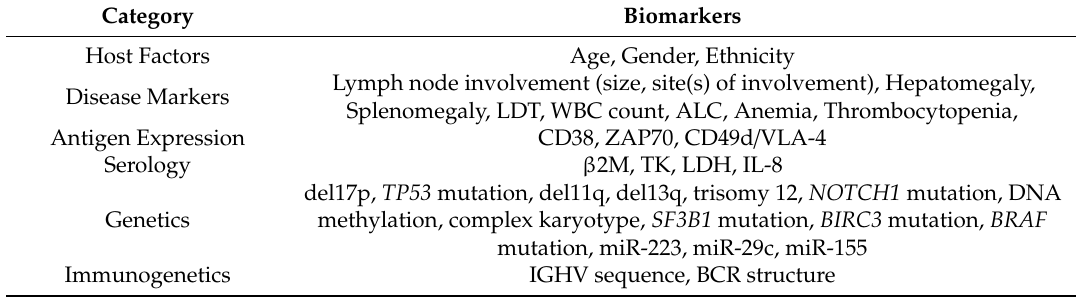
Table 1. Today’s most well-established prognostic biomarkers in chronic lymphocytic leukemia. Category Biomarkers Host Factors Age, Gender, Ethnicity Lymph node involvement (size, site(s) of involvement), Hepatomegaly, Disease Markers Splenomegaly, LDT, WBC count, ALC, Anemia, Thrombocytopenia, Antigen Expression CD38, ZAP70, CD49d / VLA-4 Serology β 2M, TK, LDH, IL-8 del17p, TP53 mutation, del11q, del13q, trisomy 12, NOTCH1 mutation, DNA Genetics methylation, complex karyotype, SF3B1 mutation, BIRC3 mutation, BRAF mutation, miR-223, miR-29c, miR-155 Immunogenetics IGHV sequence, BCR